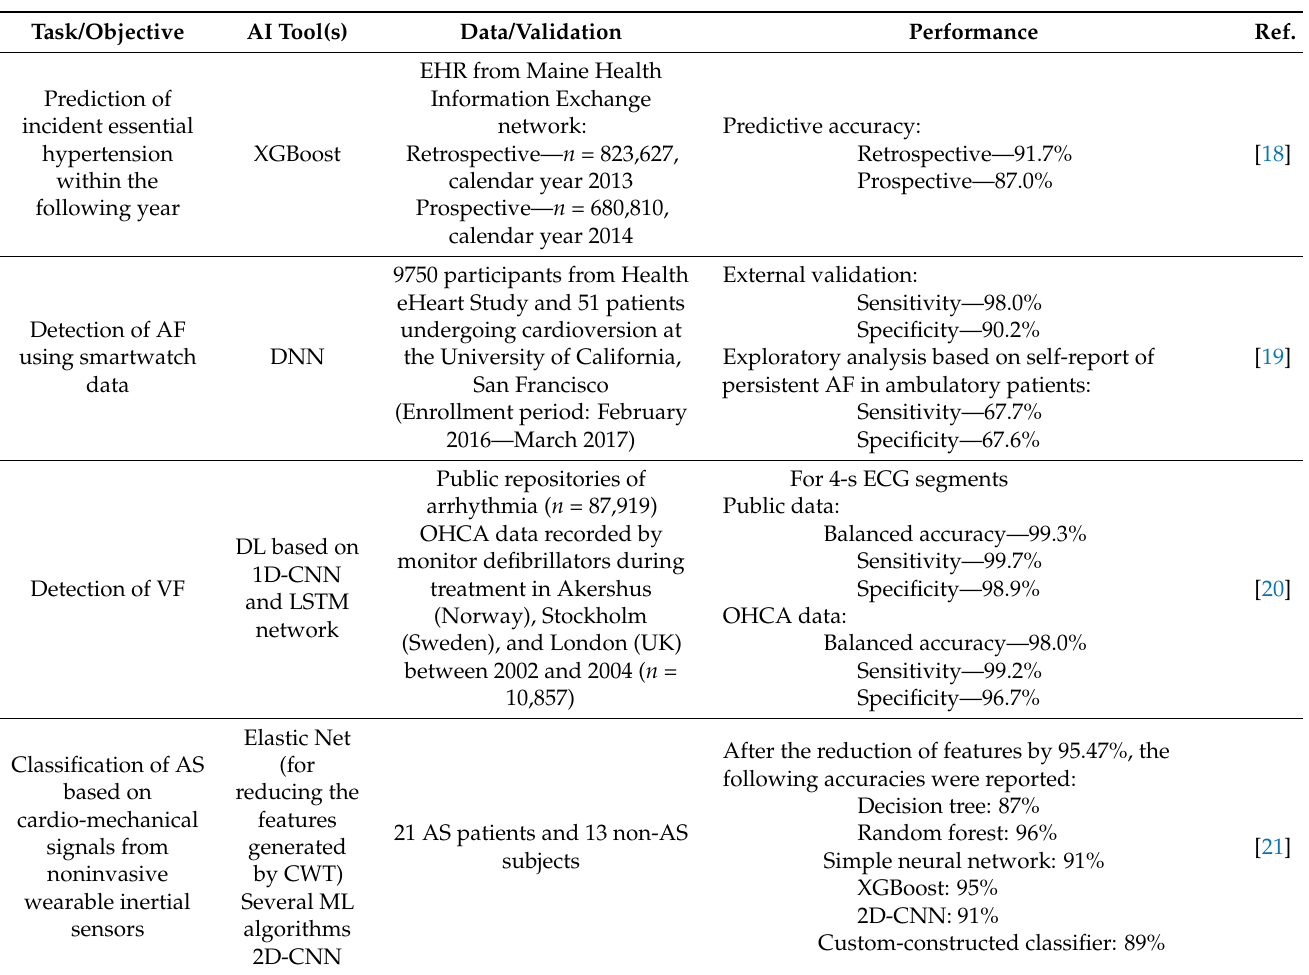
Table 2. Summary of the recent AI studies in